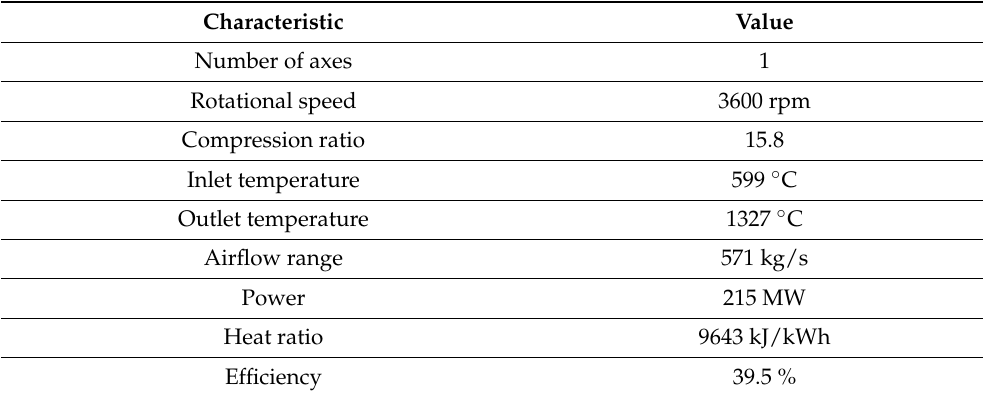
Table 1. GTL Specifications (SIEMENS,